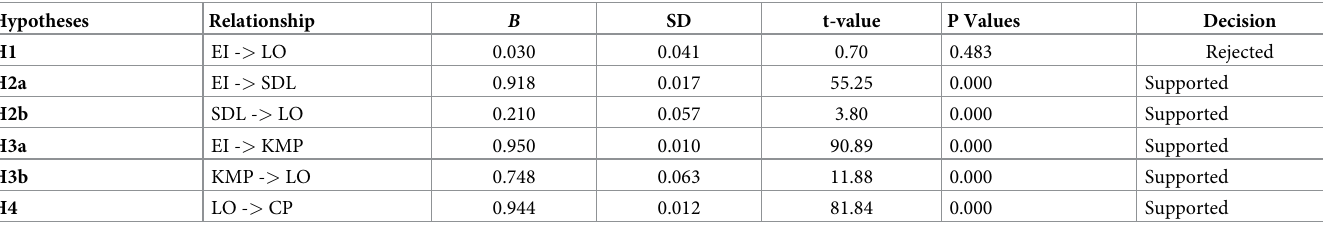
Table 4. Results of structural model path coefficient (direct